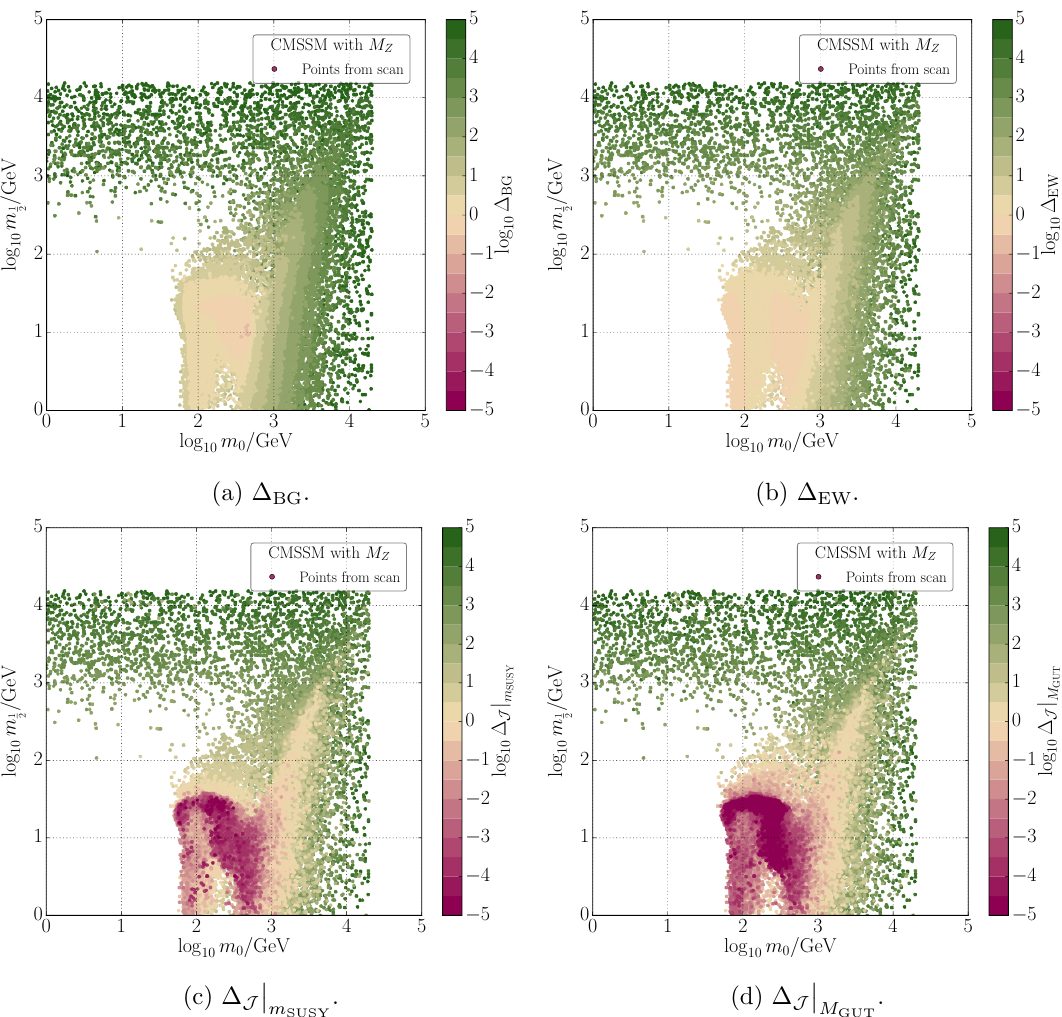
Figure 7. Comparison of (cid:12)ne-tuning measures in the CMSSM on the ( m 0 , m de(cid:12)nitions, see section